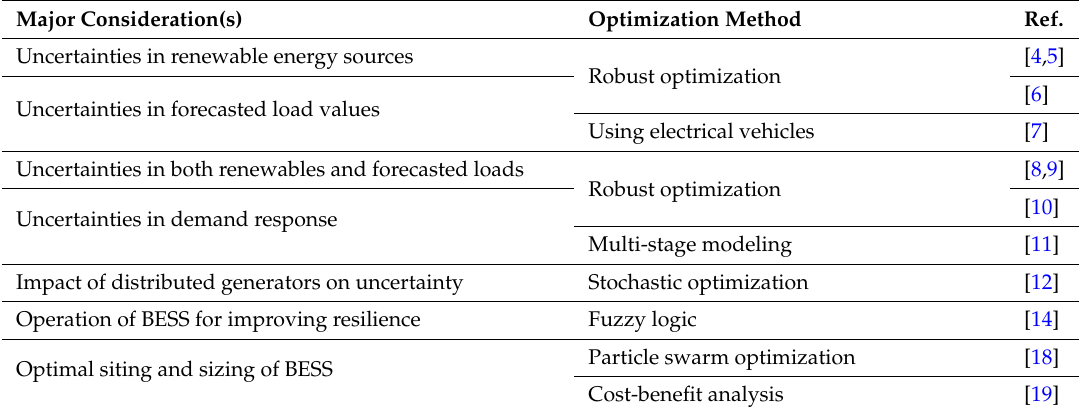
Table 1. Summary of available approaches for battery energy storage systems (BESS) and demand response (DR) with